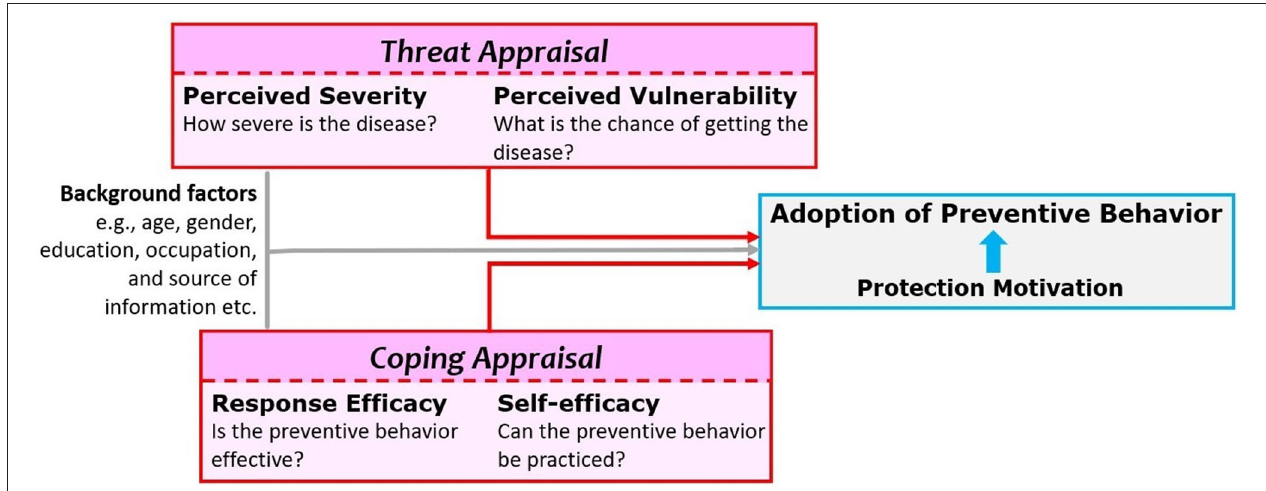
FIGURE 1 | Protection motivation theory (PMT) framework adopted for the current study. Adoption (or practice) of preventive or protective behavior is immediately preceded by motivation for the same. According to PMT, it is a resultant of threat appraisal (perceived severity and perceived vulnerability) and coping appraisal (response efficacy and self-efficacy) adjusted for the background characteristics of the